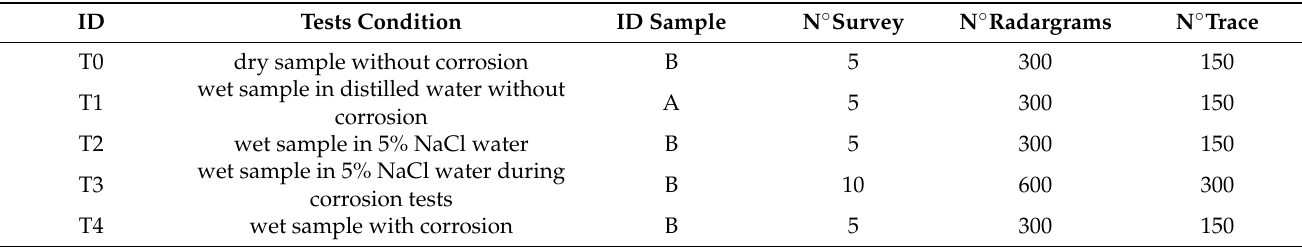
Table 1. The different scenarios and the total number of the acquired